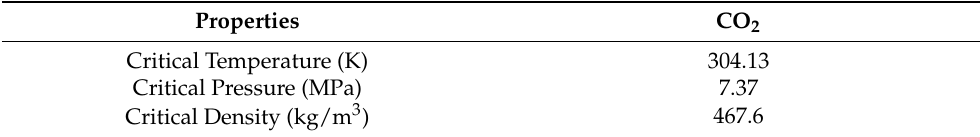
Table 1. Critical point properties of CO 2